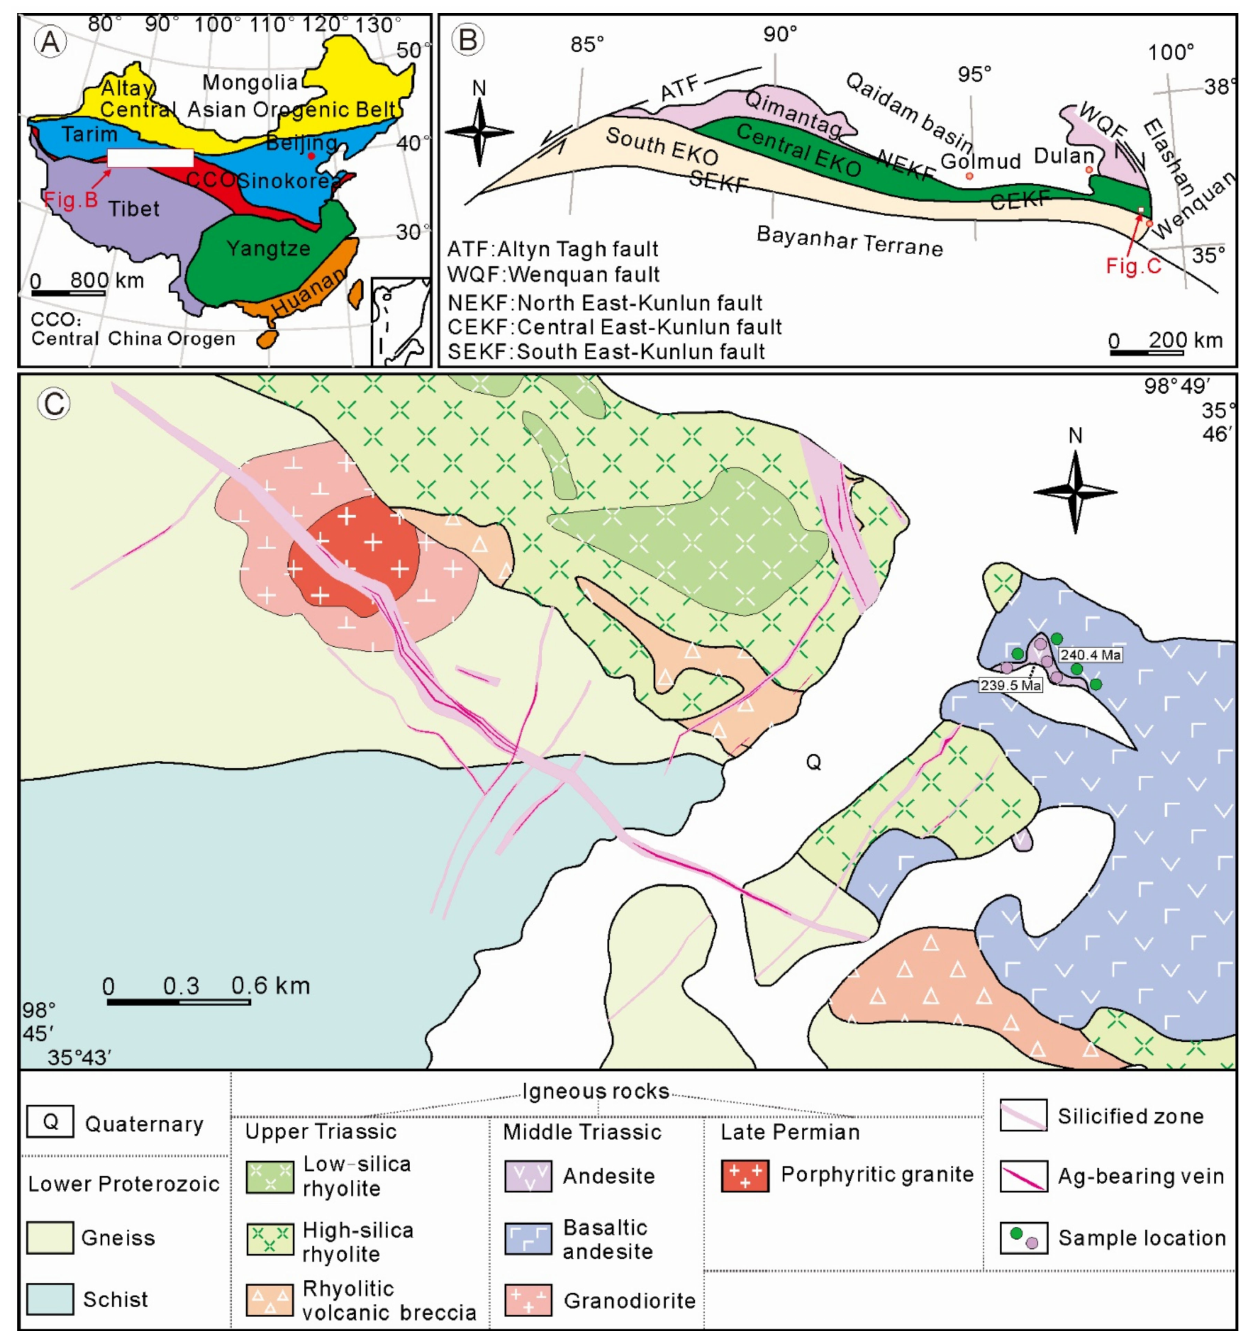
Figure 1. Schematic tectonic Maps of ( A ) China and ( B ) East Kunlun Orogen (modified after Ref. [26]); and, ( C ) Simplified geologic Map of the Nageng area, showing the distributions of